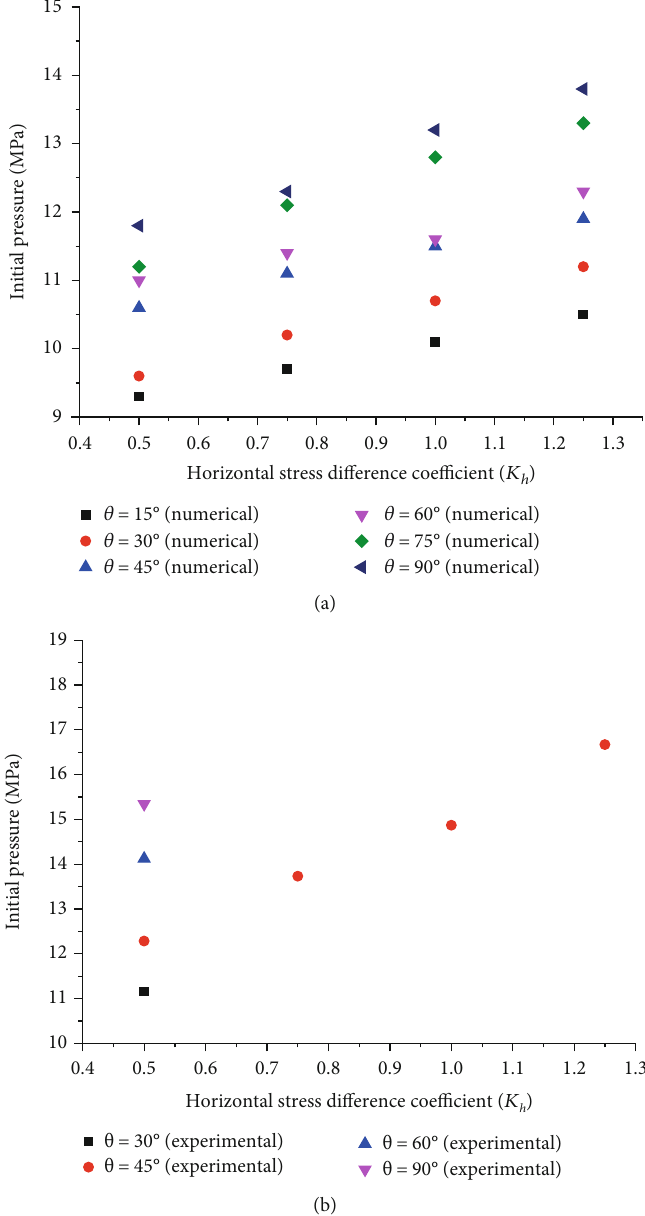
Figure 12: Variation of initial pressure under di ff erent conditions from (a) numerical calculation results and (b) physical experimental results